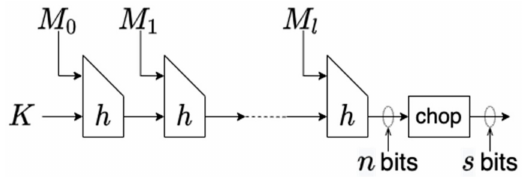
Figure 3. chopMD-MAC